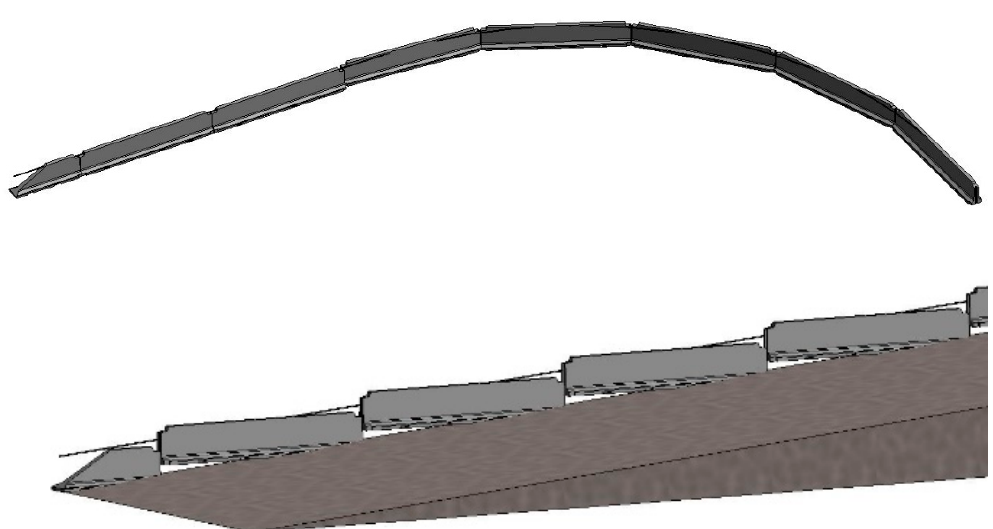
Figure 9. New Jersey guardrail extrusion and section view.